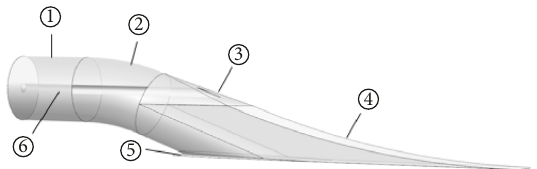
Figure 1: 3D model of inlet flow channel. ∗ ① , horizontal straight pipe section; ② , bent section; ③ , inclined straight pipe section; ④ , slope section; ⑤ , lip; ⑥ , impeller shaft.